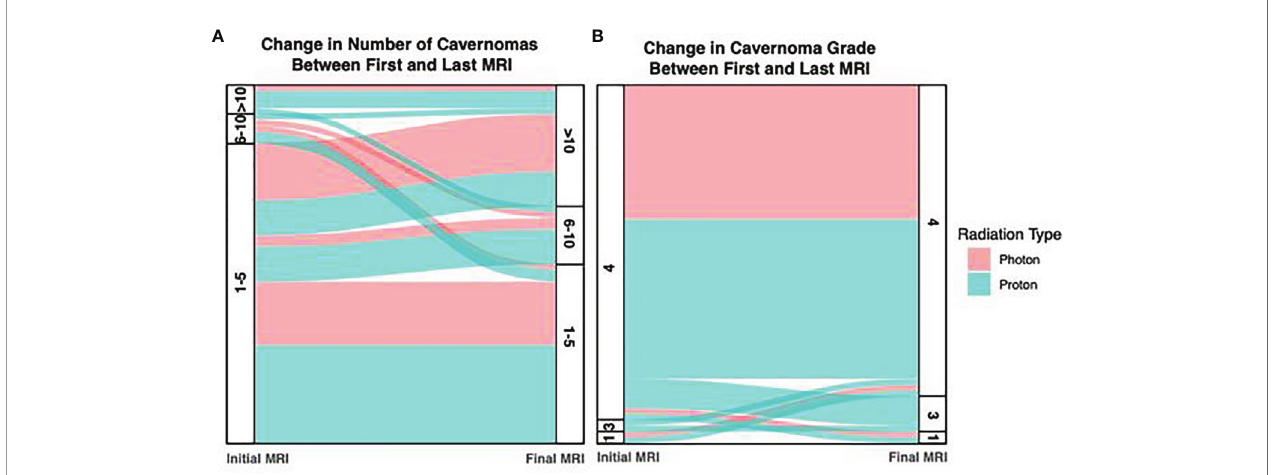
FIGURE 6 | Alluvium Plot of Number of Cavernomas and Cavernoma Grade on Initial and Final Imaging. (A) The number of cavernomas detected increased between the initial and fi nal surveillance imaging, however differences between the photon and proton groups were mild. (B) In photon patients, the number of grade 4 lesions (dot-like) were consistent over both imaging timepoints, however the number of grade 4 lesions decreased in proton patients, suggesting progression of some